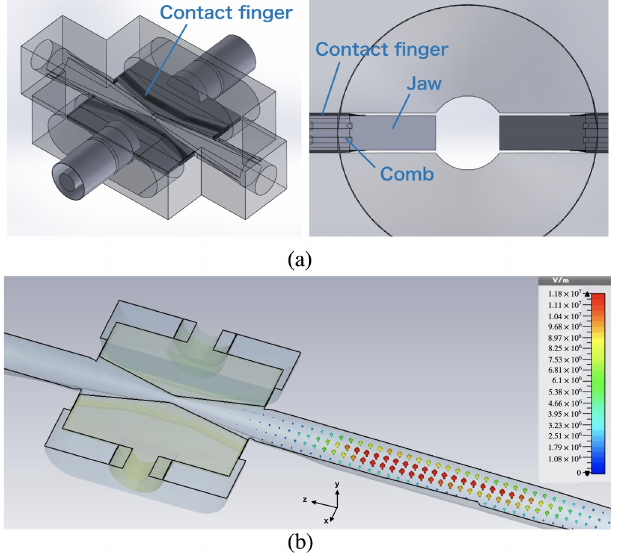
FIG. 5. (a) Simulation model and (b) electric field strength in TE 111 ;y mode (1.9849 GHz), calculated with CST STUDIO .